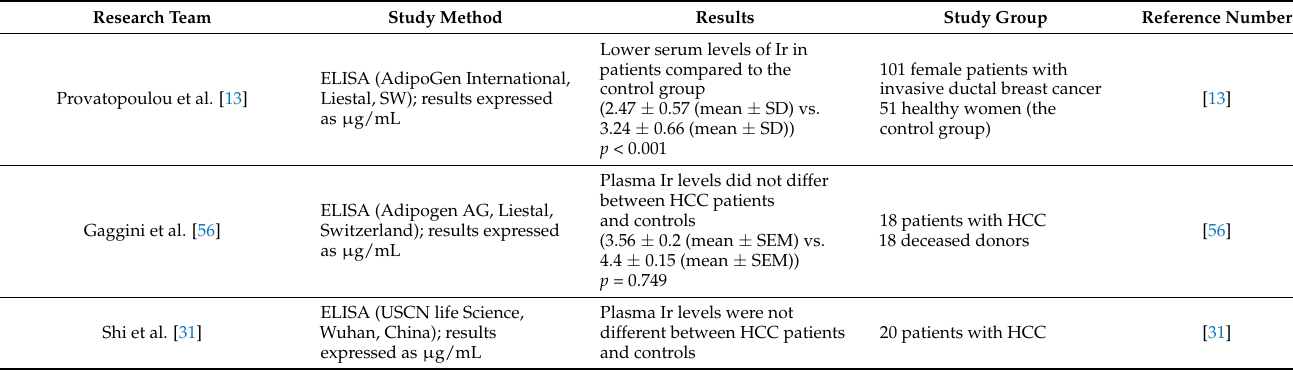
Table 2. Summary of the study results of Irisin levels in human plasma detected by ELISA. Research